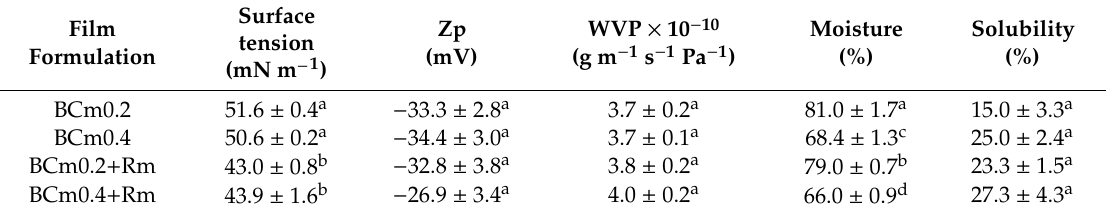
Table 3. Surface tension, zeta potential (Zp), water vapor permeability (WVP), moisture content, and solubility of black chia seed mucilage (BCm)-based